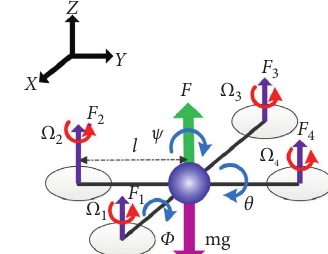
Figure 1: Four-rotor UAV.